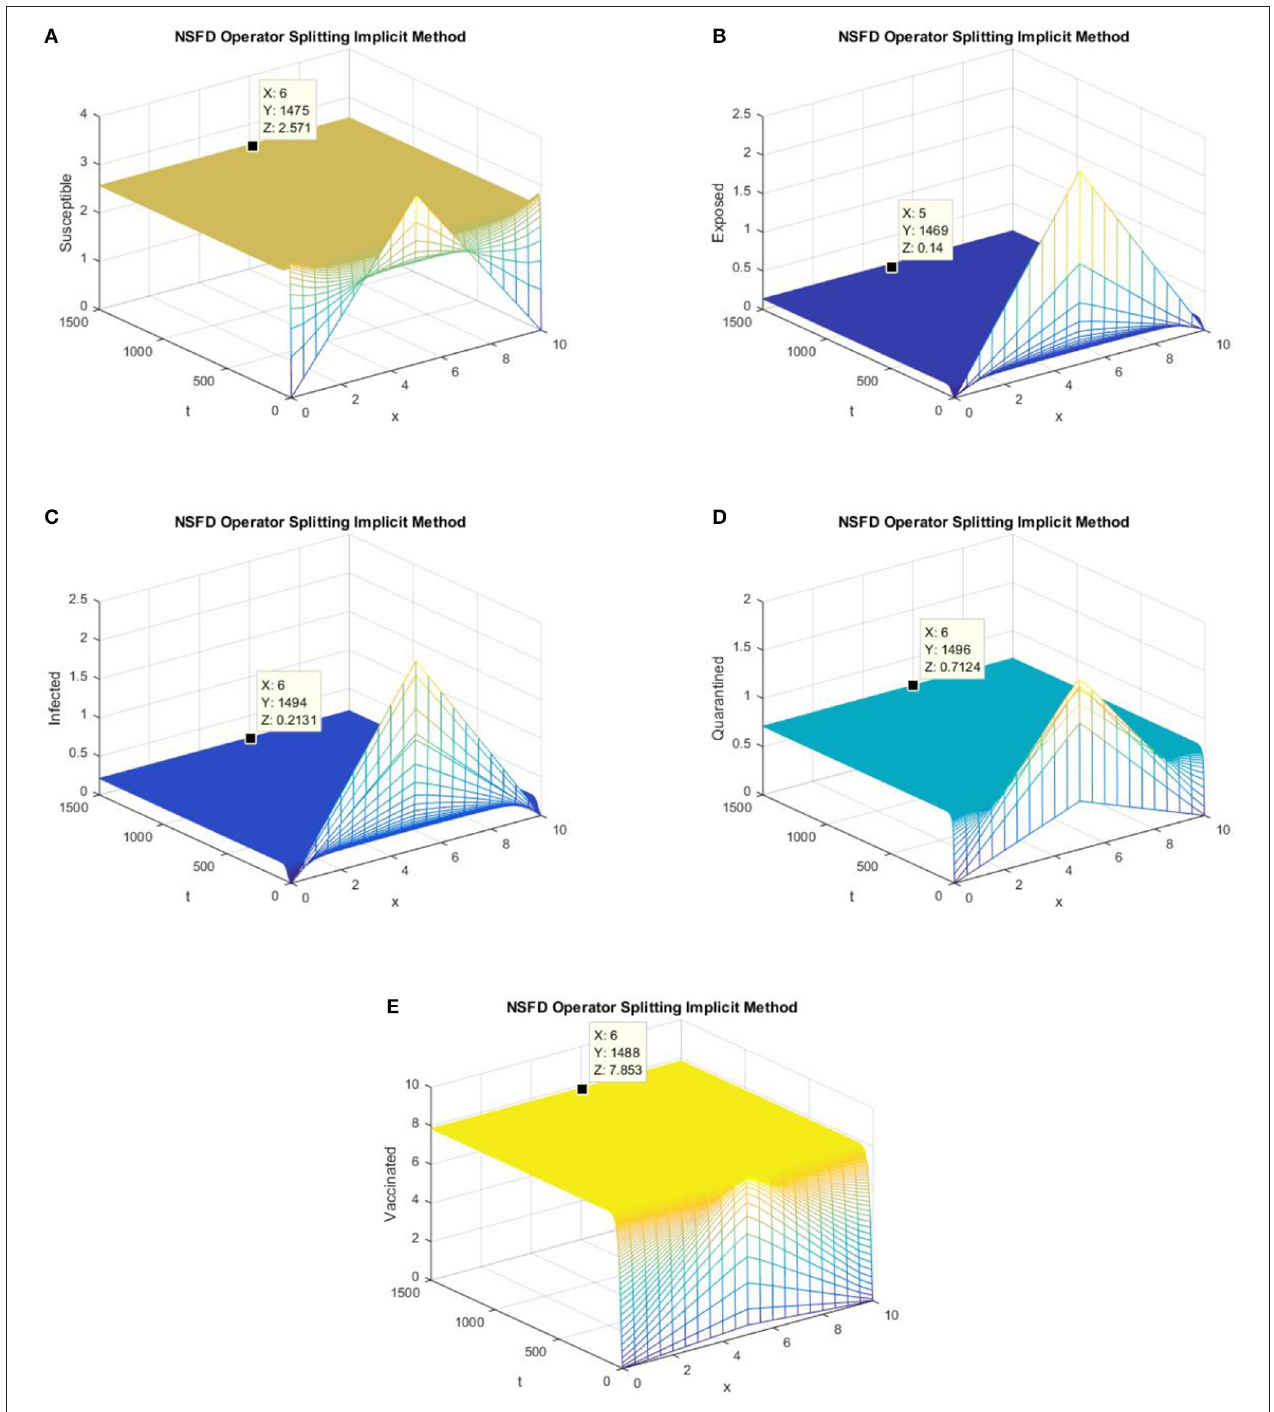
FIGURE 6 | The implicit operator splitting NSFD scheme is used to simulate graphs (A–E) . (A) Mesh graph of S ; (B) Mesh graph of E ; (C) Mesh graph of I ; (D) Mesh graph of Q ; (E) Mesh graph of V